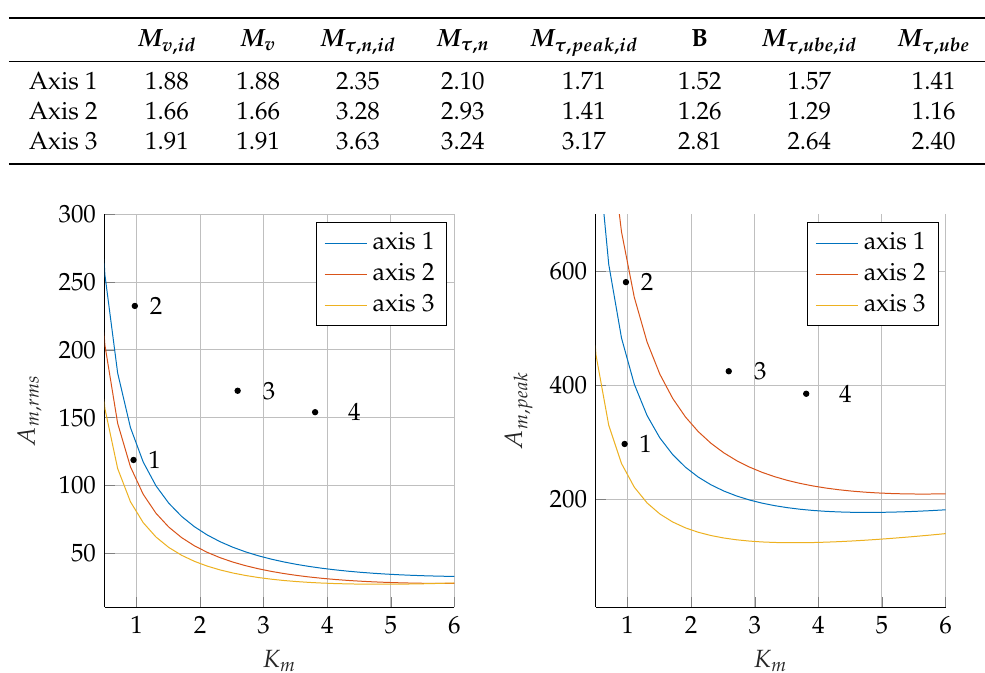
Table 3. Safety margins for ideal and non-ideal transmissions.